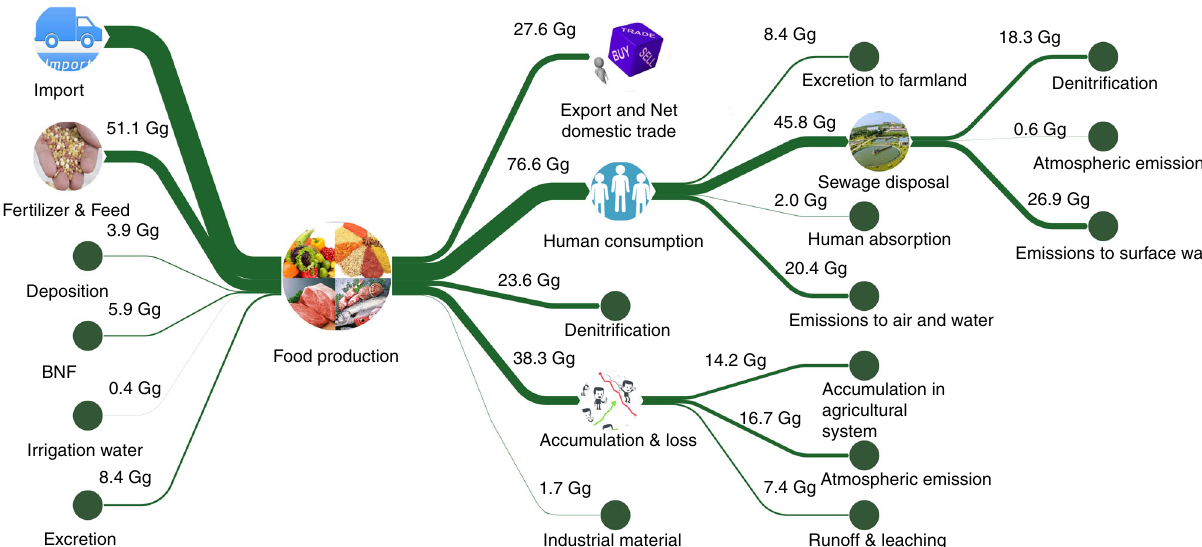
Fig. 4 Life cycle analysis of the food Nr fate of Guangzhou in 2015. Inputs of Nr to food production include import, BNF, organic and chemical fertilizer, N deposition, feed, and irrigation water, a fraction of Nr is for human food consumption, the rest is transferred outside the system or lost to the environment. BNF, biological N fi xation; Units are in Gg N y − 1